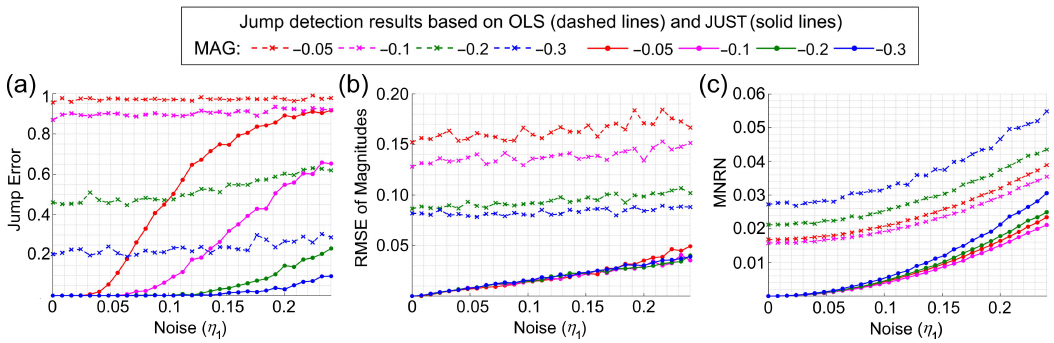
Figure 6. Same caption as Figure 5 but for collections of three-year-long time